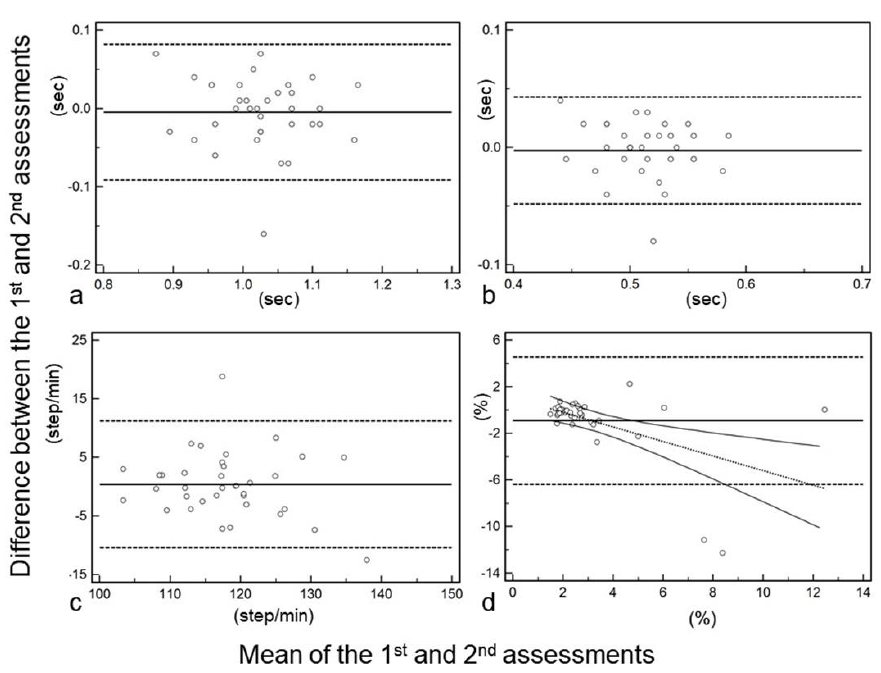
Figure 4. Bland-Altman plots of the gait parameters, showing good intraclass correlation coefficient (ICC; ( a ) stride time, ( b ) step time, ( c ) cadence) and poor ICC (( d ) coefficient of variation). Height significantly correlated with number of steps ( ρ , p -value and the 95% confidential